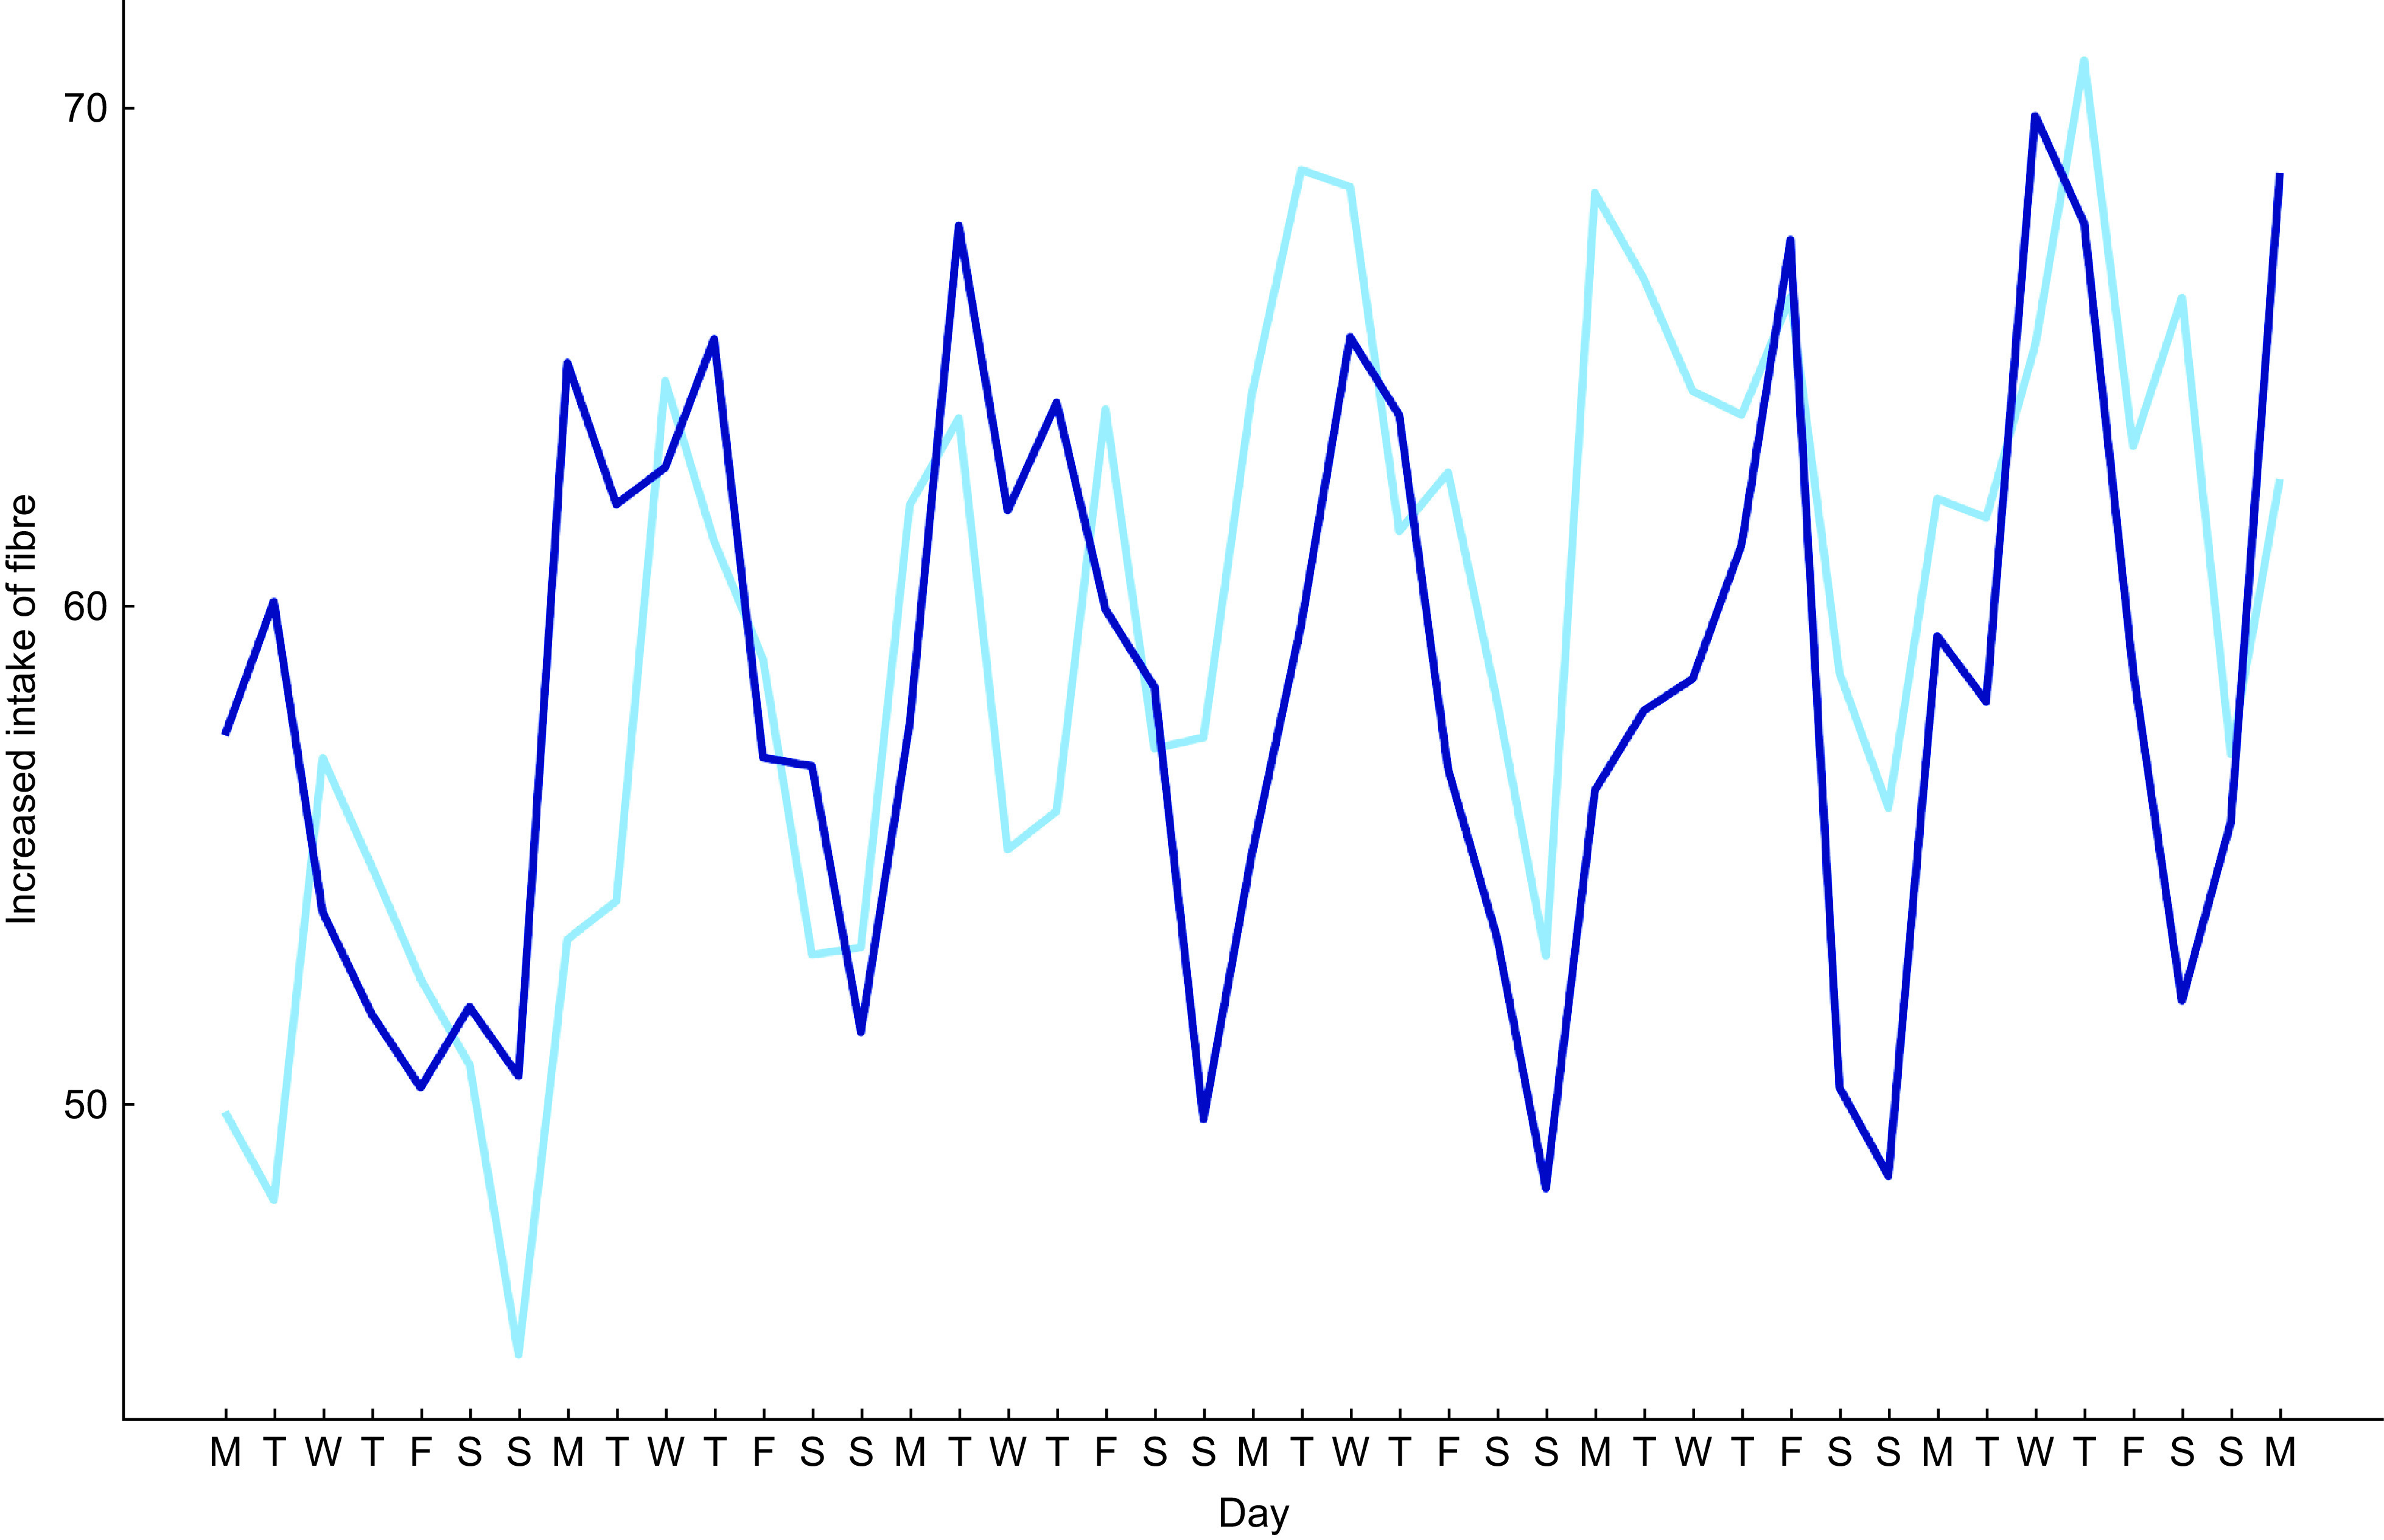
Answers to ‘did you manage to eat more fibre today’ did not differ between groups. Daily assessed using smartphone-based ecological momentary assessment (EMA). Answers were rated on a visual analogue scale rating from 0 ‘not at all’ to 100 ‘yes, very much’. , GA; , personalised dietary advice (PDA)